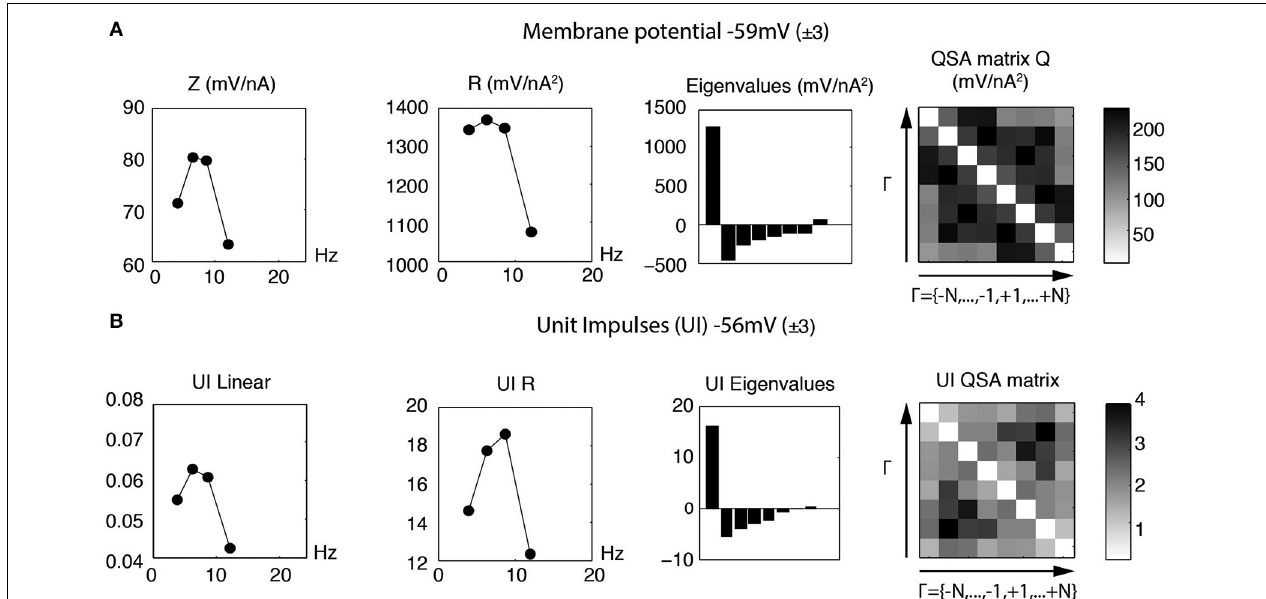
potential. (B) Analysis of suprathreshold unit impulses. The linear and quadratic behaviors for the subthreshold and suprathreshold responses have similar form for these resonance